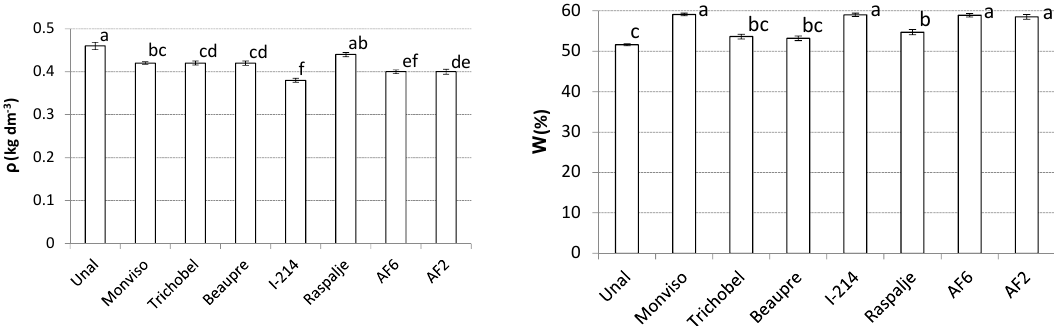
Figure 3. Mean and standard errors of the basic density ( ρ , kg·dm − 3 , left) and the fresh humidity content (W, %, right) for the eight genotypes studied. Different letters denote significant differences (Tukey test).